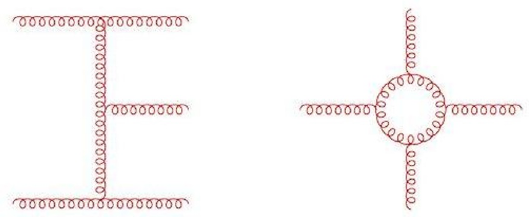
Figure 12. Gluon diagrams representing the structure of the exponentiated colour factors appear- ing at four